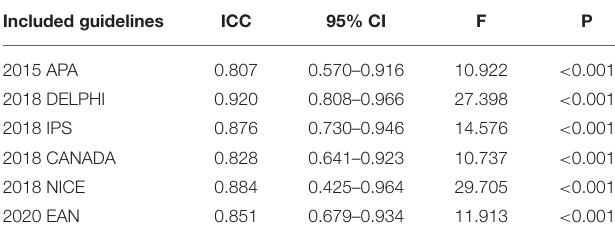
TABLE 3 | Results of inter-rater reliability (ICC) for each